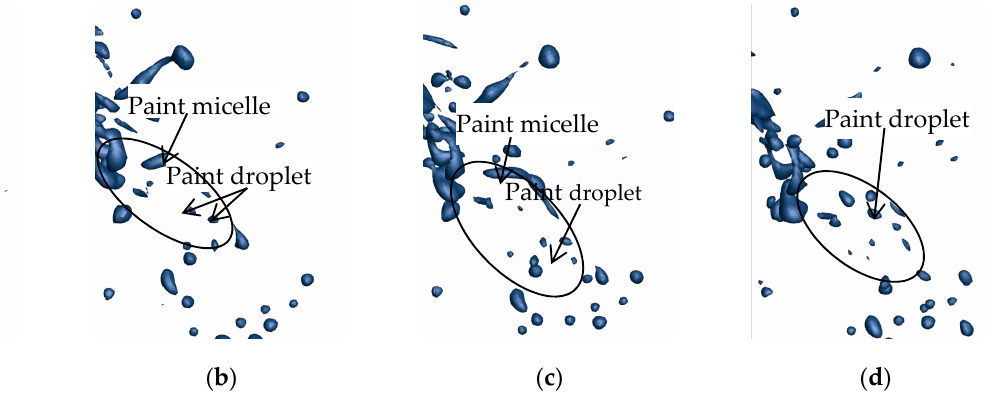
Figure 13. Formation process of paint micelles: ( a ) 2.066 ms, ( b ) 2.077 ms, and ( c ) 2.084 ms.